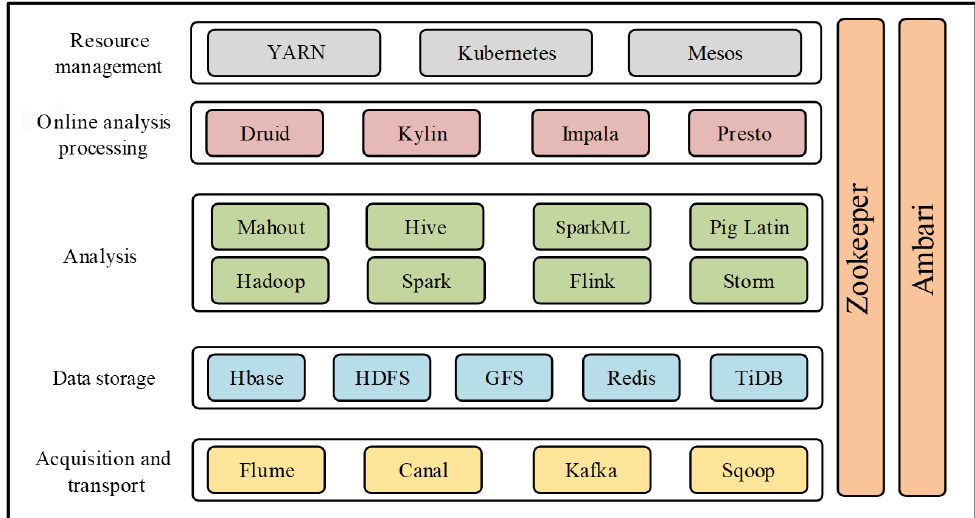
Fig. 1 Distributed computing technology stack for handling big